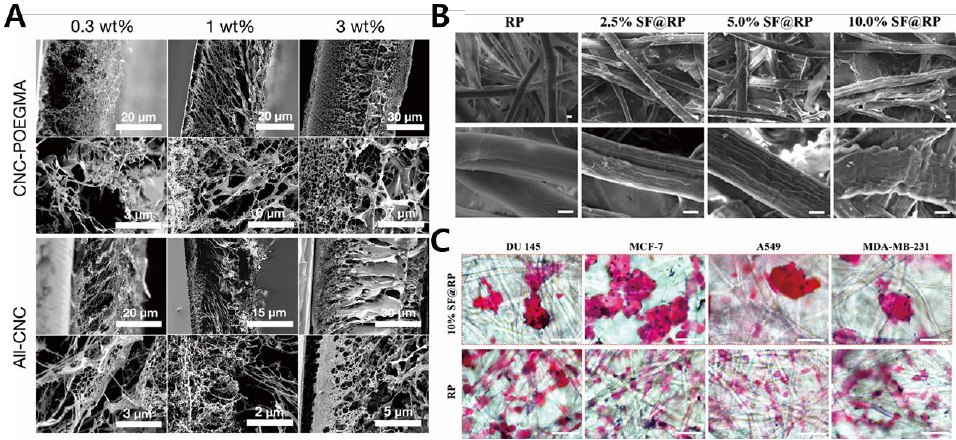
Figure 3. ( A ) Cross-sectional SEM images of the fabricated aerogel composite films with its porous 3D scaffolds. ( B ) FE-SEM microscopy of silk fibroin (SF)/rice paper (RP) composites with different concentrations indicating fibrous scaffolds. ( C ) Bright-field images of DU 145, MCF-7, A549, and MDA-MB-231 stained with H&E (red) in SF scaffolds. Reprinted with permission from [34]. Copyright 2019, American Chemical Society; Reprinted with permission from [35]. Copyright 2020, American Chemical Society.